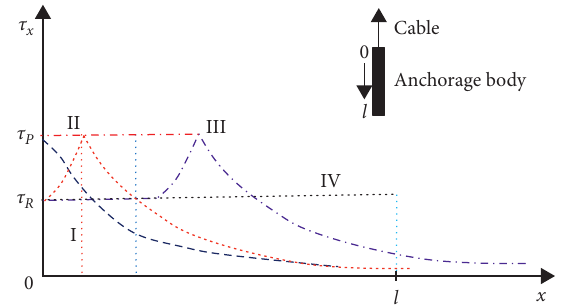
Figure 10: The evolution process of shear stress with uniform- exponential